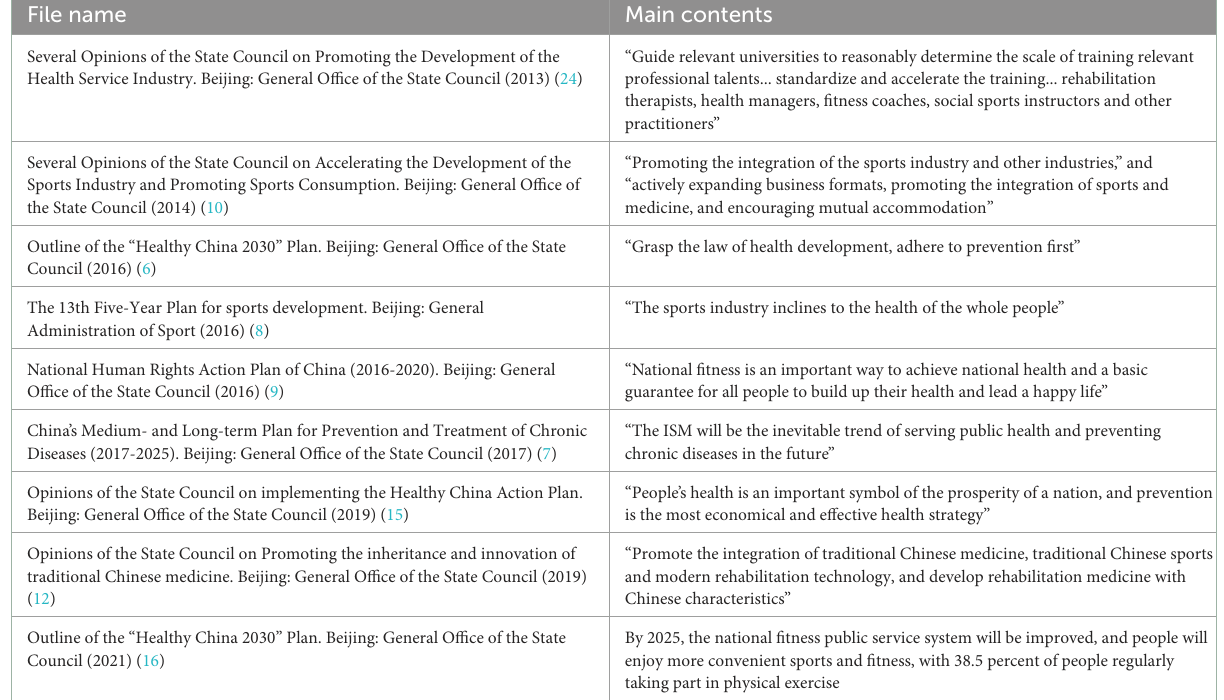
TABLE 1 Policies or documents related to the